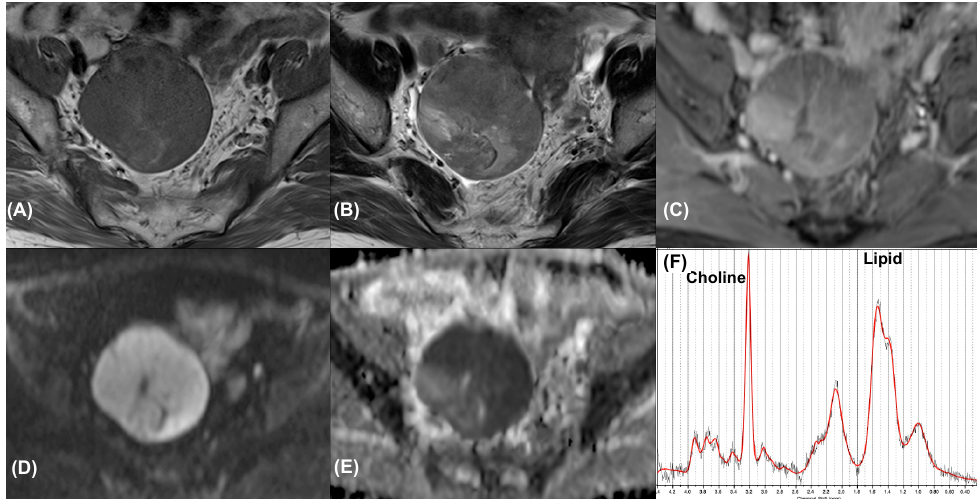
( F ) MR spectroscopy depicts prominent resonances corresponding to lipids (demonstrated using the FID-A toolkit [16]). the FID-A toolkit [16]).